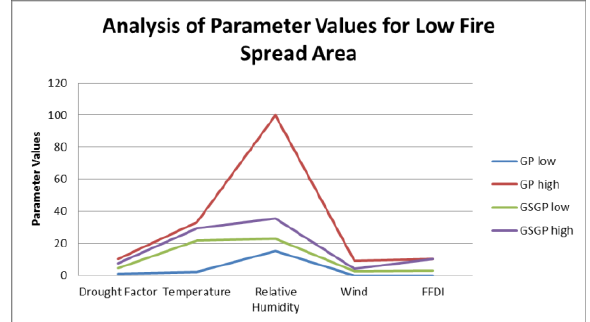
Fig. 2. Analysis of Parameter Values for Low Fire Spread Area